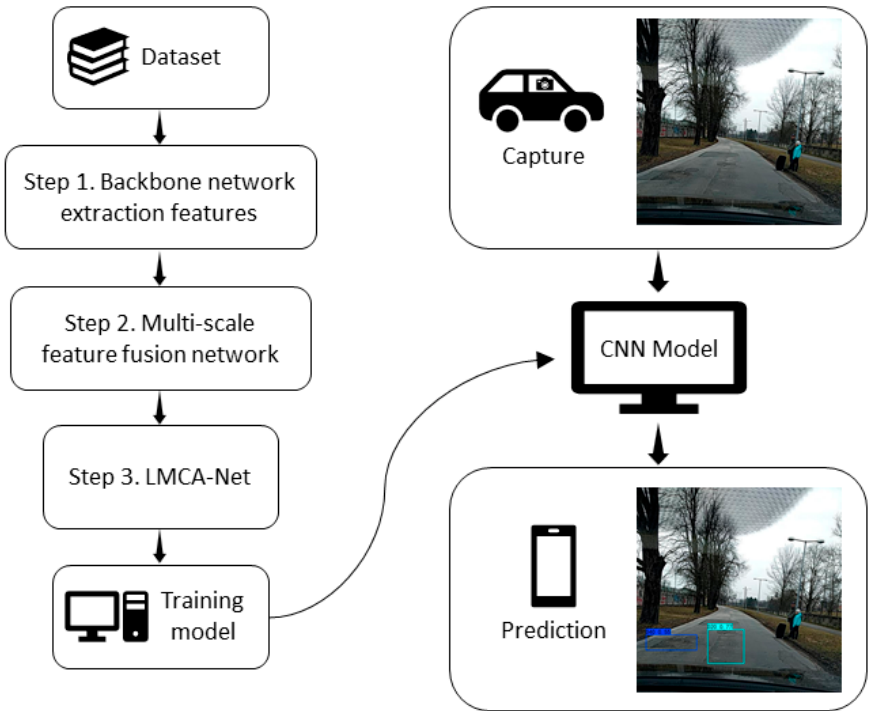
Figure 1. Flowchart of the road damage detection algorithm. The proposed network for road damage detection consists of three main steps, as shown in Figure 2: Backbone feature extraction network, Multiscale feature fusion network, and